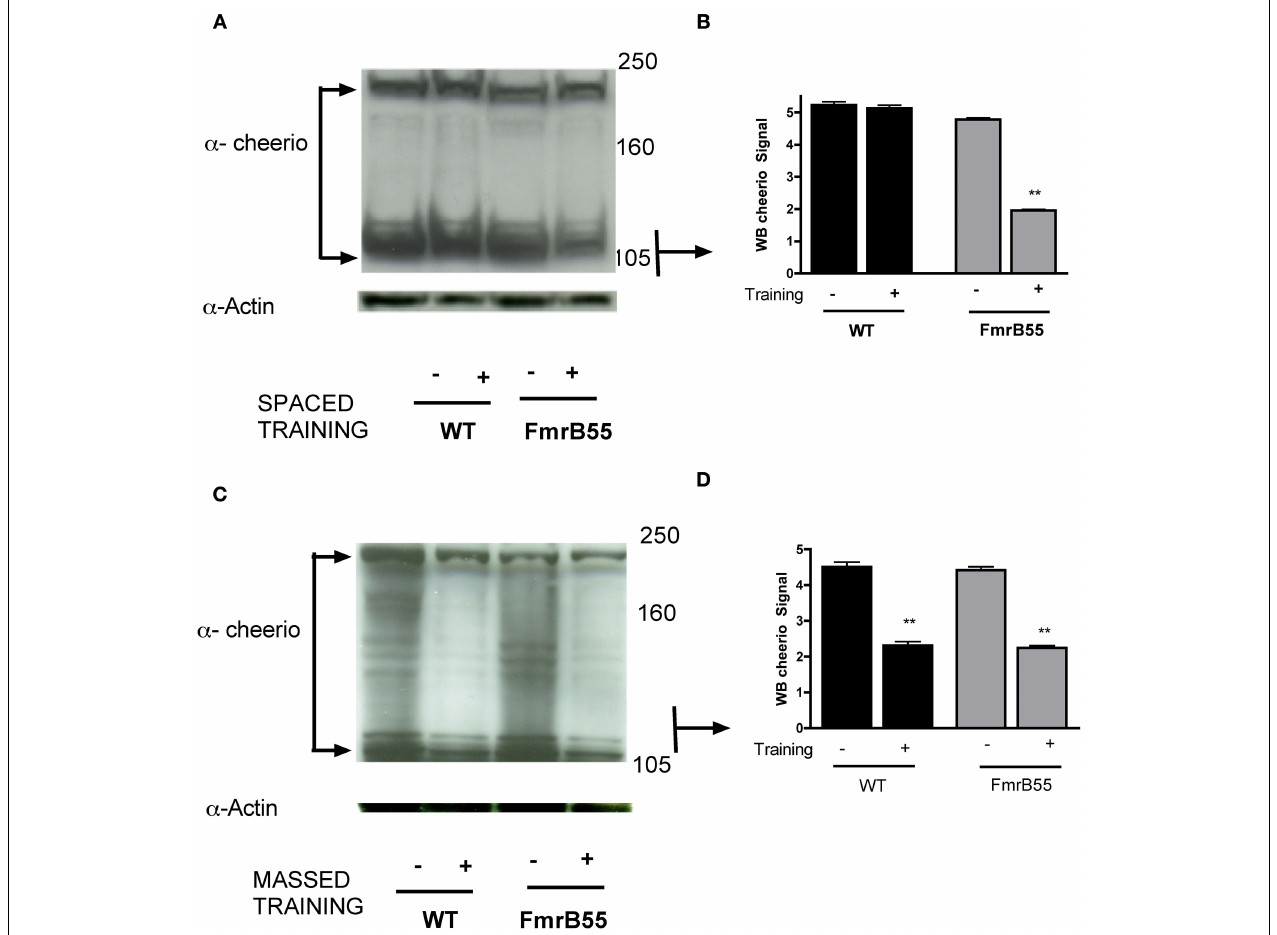
FIGURE 4 | Activity-dependent expression of Filamin A is aberrant after spaced training in the dFMR1 mutant. (A) Western blot analysis of Cheerio level before ( − ) or after ( + ) spaced training in wild-type fl ies (WT) or the dFMR1 ( FmrB55 ) mutant. All lanes were loaded with 50-ug total protein. Anti-actin (lowest band for each lane) was used as loading control. All heads were collected similarly and processed in parallel. Protein mass markers are in kD. (B) Quantifi cation of western blot analysis for the smaller isoform of Cheerio (105 kD). In wild-type ( WT ) fl ies, Cheerio short-form levels are similar before ( − ) and after ( + ) spaced training. In the dFMR1 mutant ( FmrB55 ), however, the Cheerio short-form is signifi cantly